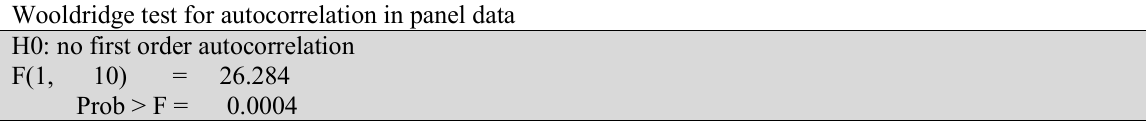
Autocorrelation Test Wooldridge test for autocorrelation in panel